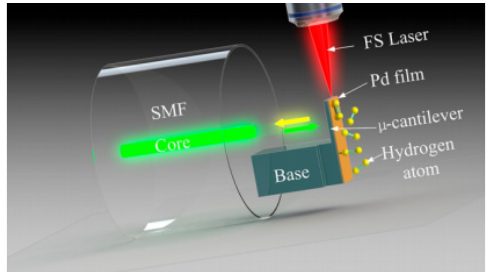
Figure 6. The polymer ‐ based fiber ‐ top microcantilever fabricated by TPP technology